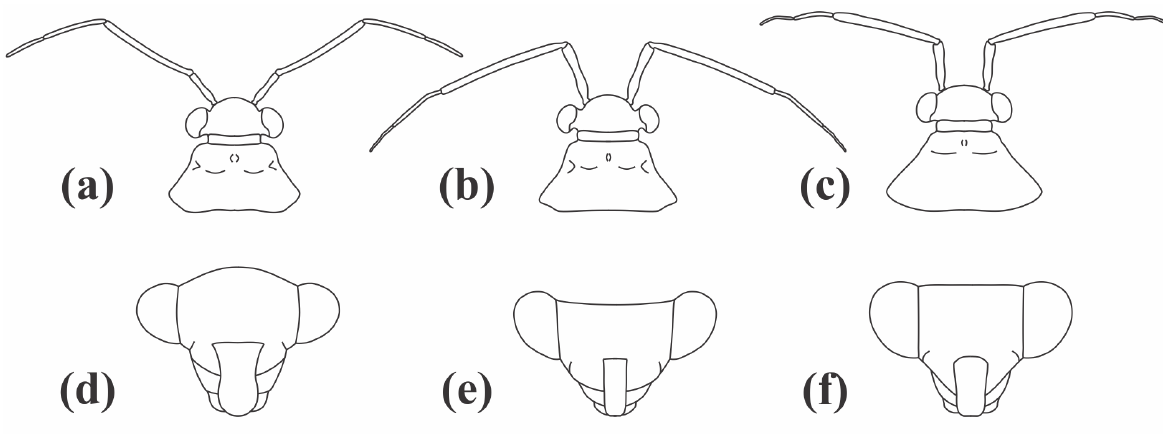
Figure 3. Head and pronotum. (a-c) dorsal view; (d-f) anterior view; (a) Neella eucosma (Stål 1862) Reuter 1908; (b) Neoneella bosqui Carvalho 1946; (c, f) Proneella boliviana Carvalho 1960; (d) Adneella columbiensis (Carvalho & Gomes 1971) Carvalho 1989; (e) Neoneella zikani Costa Lima